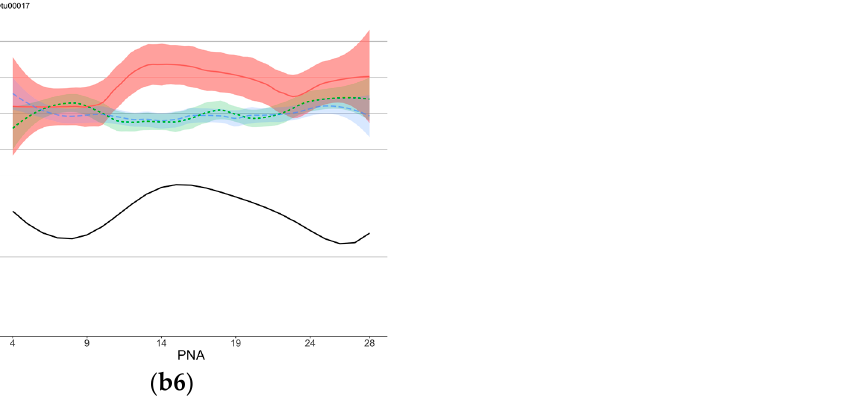
Figure 2. Control sign and OTUs for NSTRESS. ( a ) Control sign and NSTRESS. ( b ) OTUs associated with NSTRESS scores. ( a ) The proportions of the signs of the estimated coefficients of the control variables. Proportions of negative signs were shown as black blocks to the right, and those of positive signs were shown as light gray blocks to the left. Lower NSTRESS scores indicated better development, those variables in black indicated association with lower NSTRESS scores. The red dotted lines show the 90% of bootstrap. ( b1 – b6 ) The estimated time-varying effects of OTU on NSTRESS scores during the NICU stay. The x -axis represents the days after birth (PNA, postnatal age), the y -axis represents the log composition of the OTU abundance (top panel) and the estimated effect (bottom panel). The top panel “log composition” displays the trend of the log-transformed OTU compositions over the first 28 days of NICU stay for infants with different NSTRESS scores, with the infants being separated into three groups based on their NSTRESS score: high NSTRESS score (plotted in red), medium NSTRESS score (plotted in green), and low NSTRESS score (plotted in blue). The bottom panel “Estimate effect” is the estimated time-varying effects of OTUs on NSTRESS scores during the NICU stay.